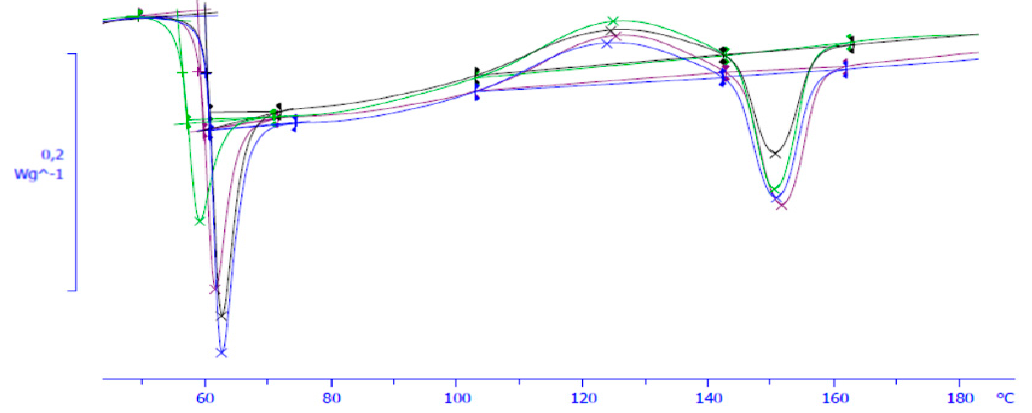
Figure 2. An example of the DSC results obtained from the PLA at different ageing times. Green: 14 days ageing; purple: 28 days ageing; black: 84 days ageing; blue: 140 days ageing.